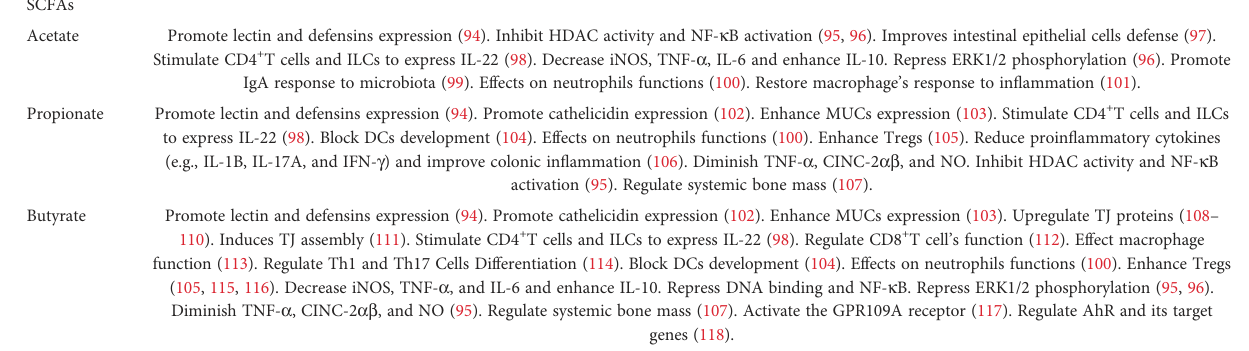
TABLE 3 Intestinal microbiota metabolites and their possible functions in AS. Intestinal microbiota metabolites